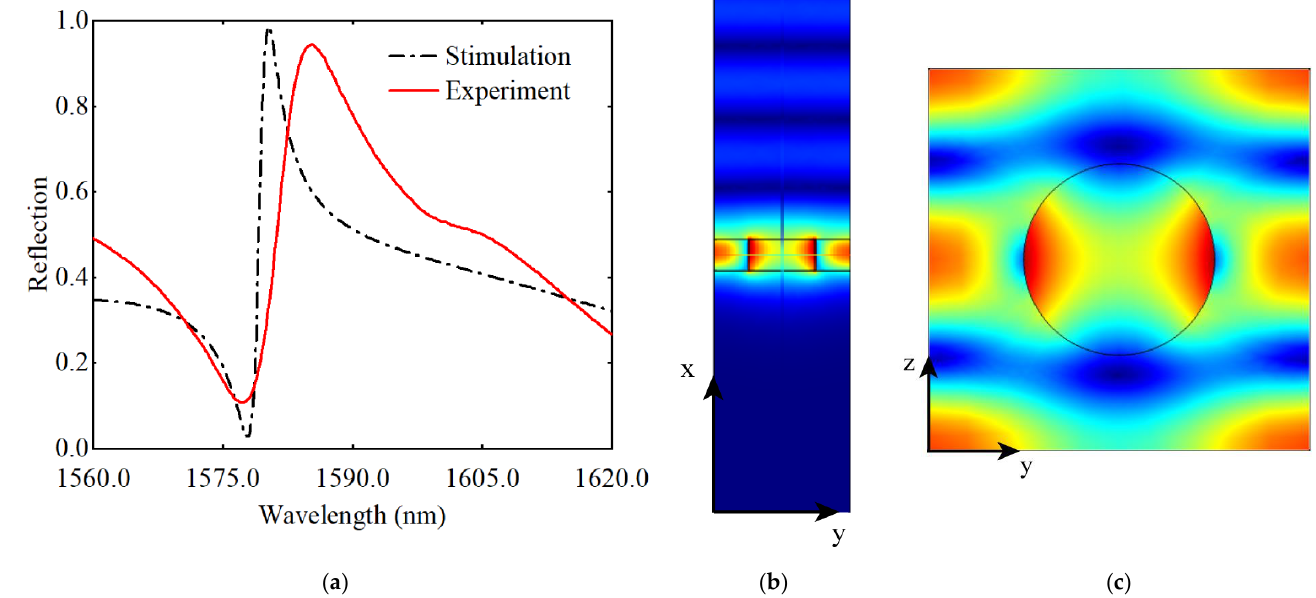
Figure 5. ( a ) The reflection of the LN metasurface in the wavelength range of 1560 nm – 1620 nm. The red line and black line are the experimental and simulated results, respectively; ( b ) Optical field distribution in xy plane; ( c ) Optical field distribution in yz plane.